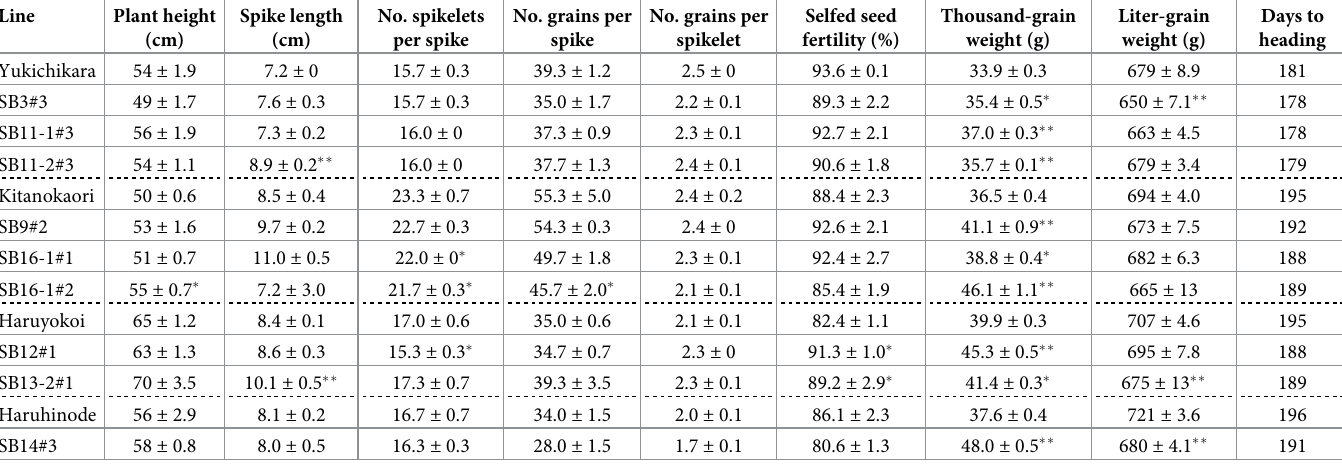
Table 1. Plant morphological characters in the selected early flowering lines and their four parental cultivars.